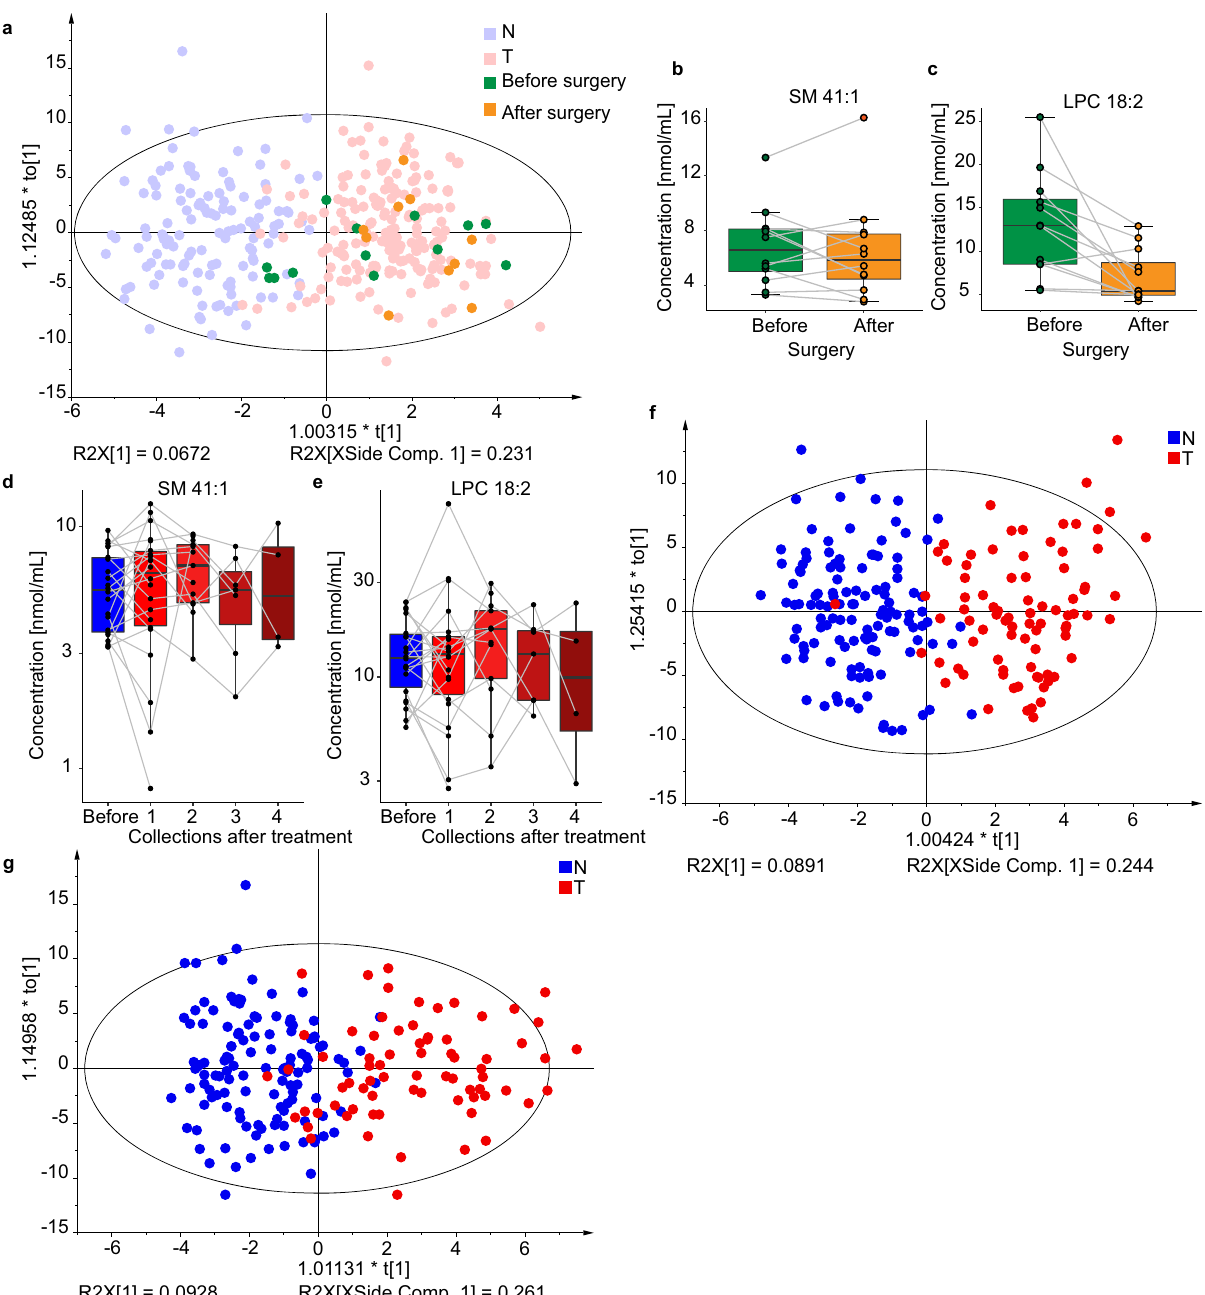
Fig. 8 Results for the lipidomic pro fi ling of human serum samples for PDAC patients (T) and healthy controls (N) including both genders in Phase III. In fl uence of surgery on the lipidomic pro fi le: a OPLS-DA for females (211 T + 124 N) using the training set with highlighted samples before (green, n = 13) and after (orange, n = 10) surgery. Box plots of molar lipid concentrations for paired samples collected before and after surgery for both genders (2 males and 10 females): b SM 41:1, and c LPC 18:2. Box plots for paired samples collected before ( n = 22) and after treatment ( n = 22 for collection 1, n = 12 for collection 2, n = 7 for collection 3, n = 4 for collection 4) for both genders using molar concentrations: d SM 41:1, e LPC 18:2. In each box plot, the centerline represents the median, the bounds represent the 1st and 3rd quartile and whiskers span 1.5 fold inter-quartile range from the median. OPLS-DA models only for subjects before any treatment or surgery separately for f males (83 T + 122 N) and g females (72 T + 124 N). Source data are provided as a Source Data fi